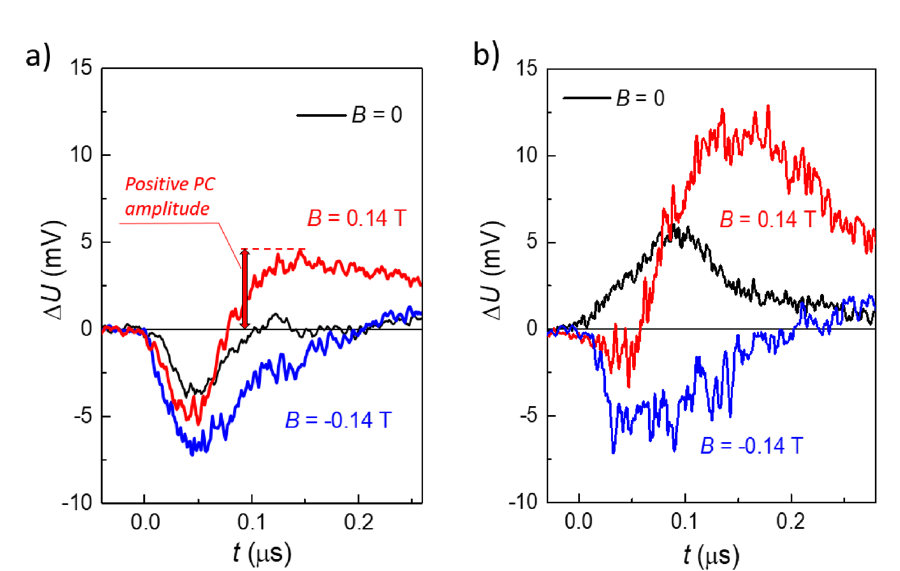
Figure 1. Sequence of layers in heterostructures under study. The graph at the right panel represents the CdTe content x distribution in the sample active part. The cap layer indicated by dark gray at the right panel was removed in the etched structure.